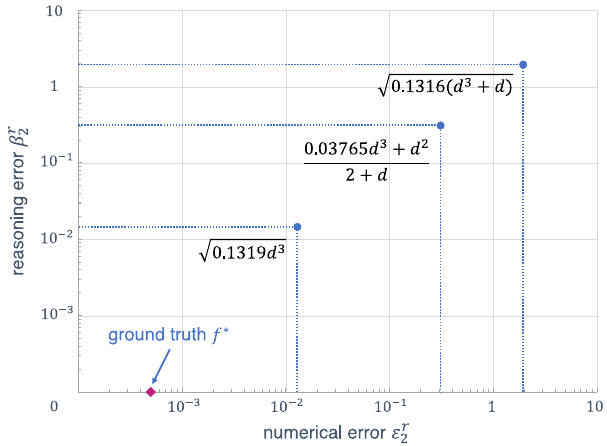
Fig.4|DepictionofsymbolicmodelsforKepler ’ sthirdlawofplanetarymotion giving the orbital period of a planet in the solar system. The models produced by our SR system are represented by points ( ε , β ), where ε represents distance to data, and β represents distance to background theory. Both distances are com- puted with an appropriate norm on the scaled ð f (cid:2) f Þ = f , reproduced in the Supplementary Information. We take 0 0 theaxiomsfor derivationofthe time dilation formulafromthework of